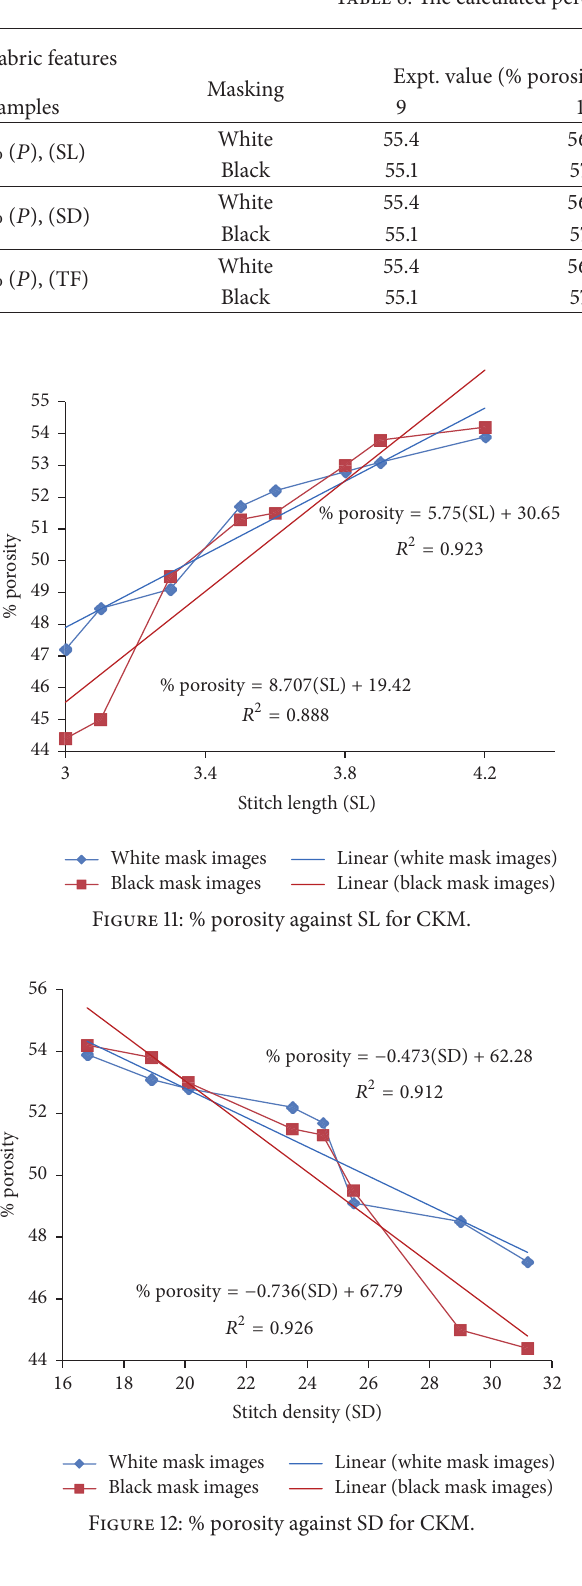
Table 8: The calculated percentage of error (CKM samples).